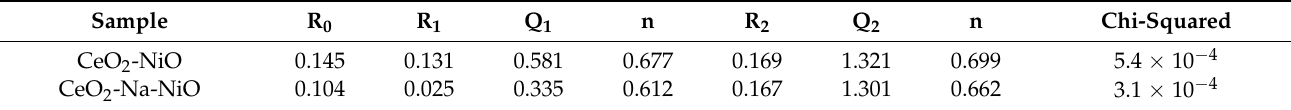
Table 1. EIS Fitted Data Using ZSimpWin Software @ 530 ◦ C, Where R and C are in Ω cm 2 and Yo[(S-s) n cm − 2 ], Respectively.